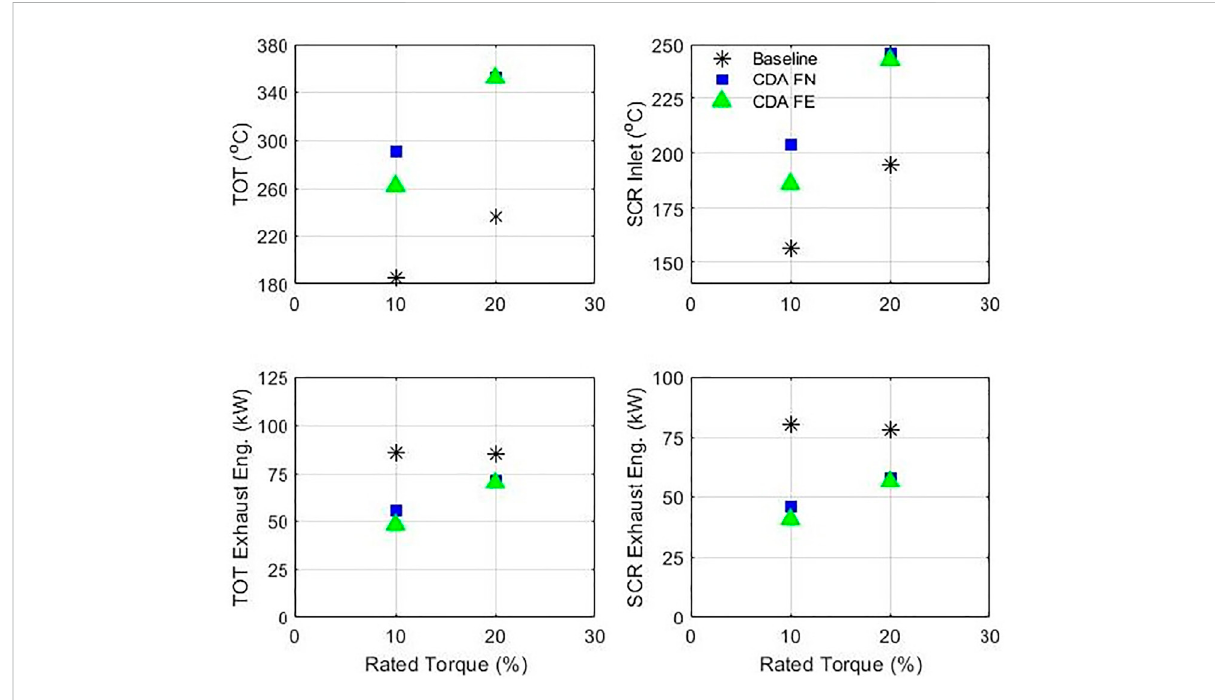
FIGURE 7 1200 rpm steady state exhaust parameters.